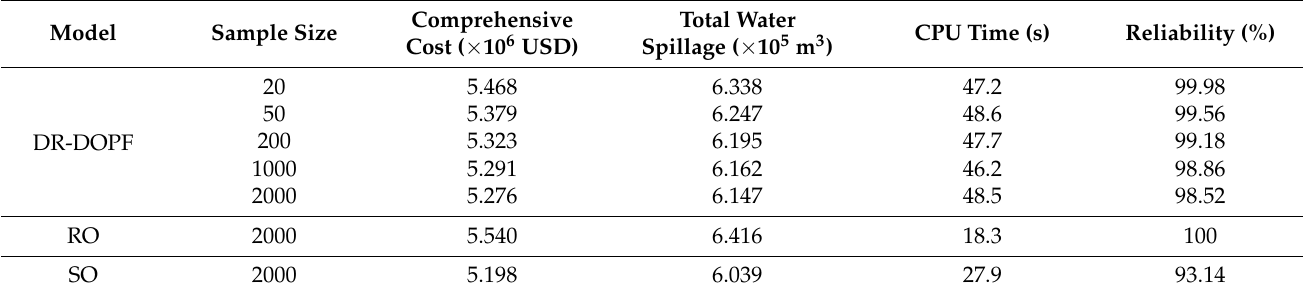
Table 5. Comparison of the DR-DOPF, RO, and SP